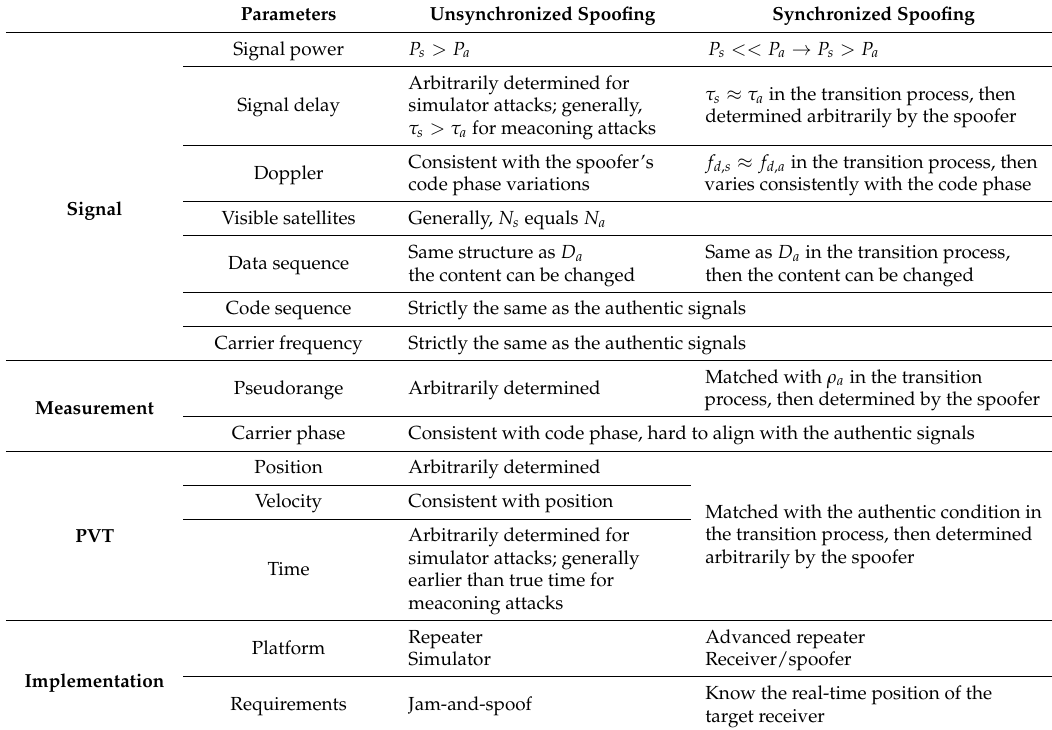
Table A1. A comparison between unsynchronized and synchronized spoofing